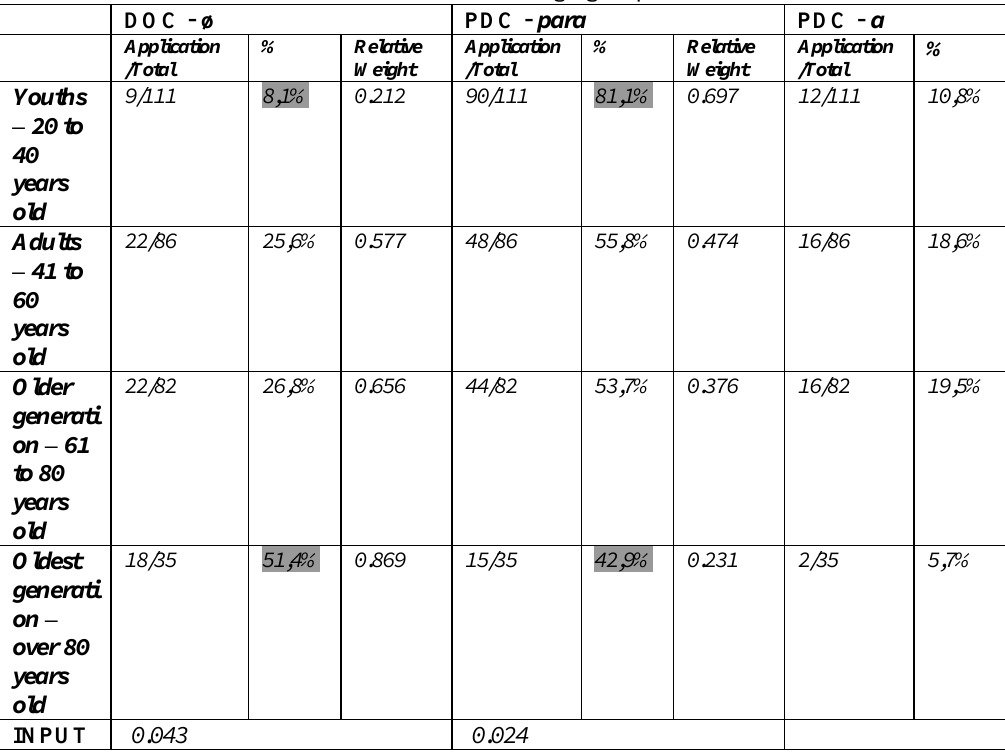
Table 1. Use of dative constructions in relation to age